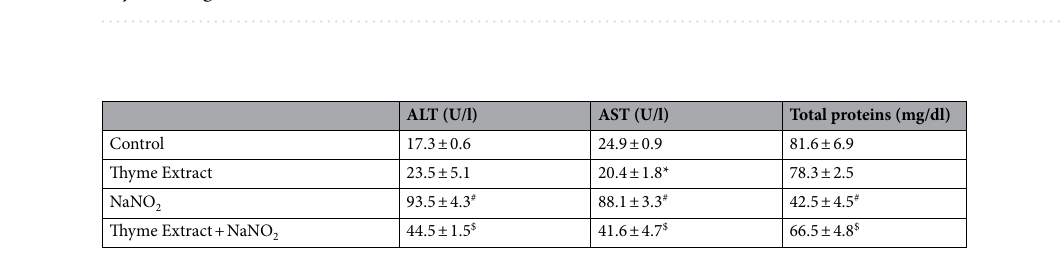
against NaNO 2 -induced hepatic toxicity (Table 5). The effect of T. vulgaris extract on the glutathione system was evaluated by determining the ratio of GSH to oxidized glutathione (GSSG) in serum from NaNO 2 -intoxicated mice (Table 5). The T. vulgaris extract had a positive effect on the glutathione status in NaNO 2 -injected mice by causing a concomitant increase in GSH levels and decrease in GSSG levels, which restored the GSH/GSSG ratio to control levels. The profound decrease in the GSH/GSSG ratio induced by NaNO 2 was normalized by T. vulgaris treatment for 15 days.